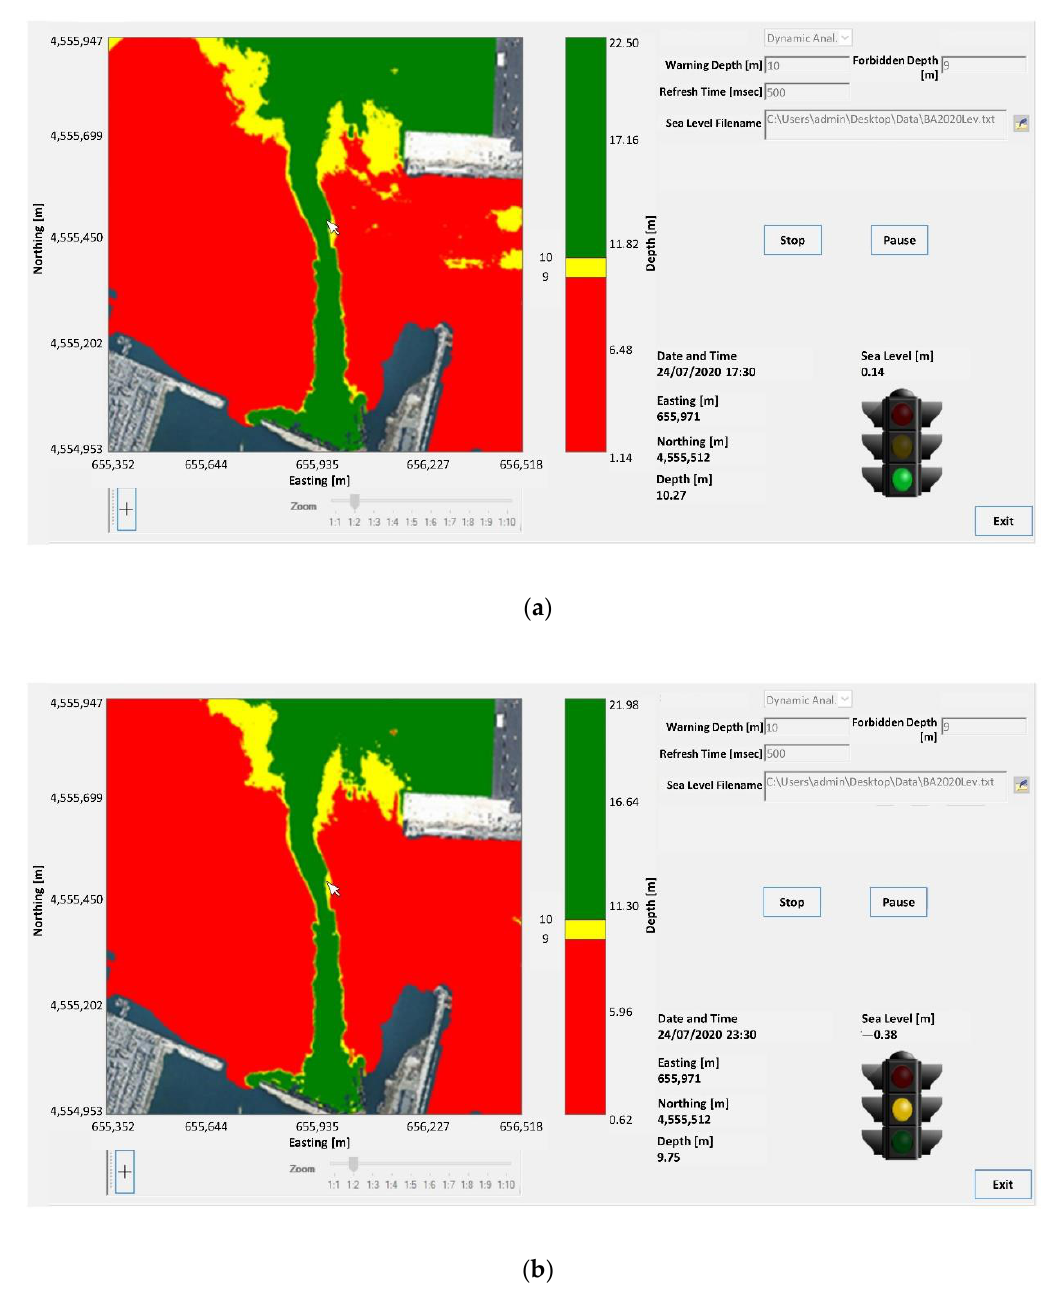
Figure 15. Detail of virtual traffic lights in the port of Bari on 24 July 2020: ( a ) at 17:30; ( b ) at 23:30; thresholds equal to 9 and 10 m.